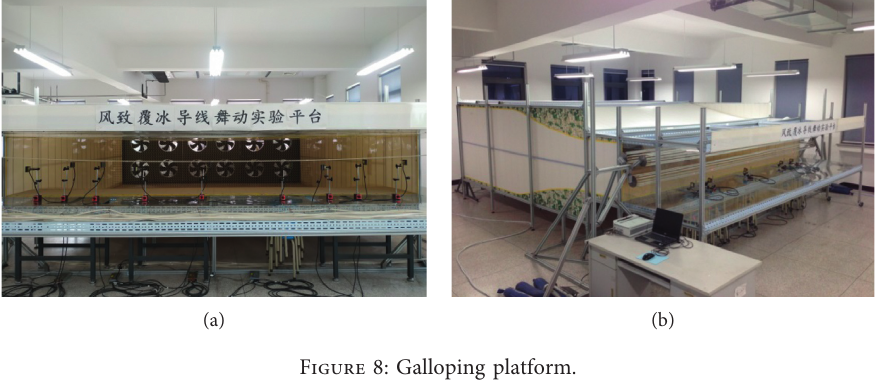
Figure 8: Galloping platform.